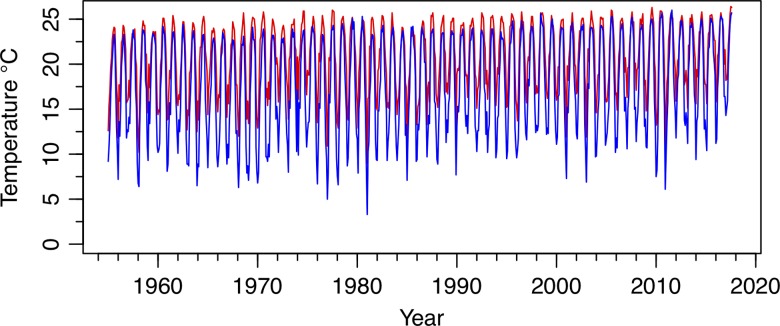
Temperature trends in Tampa (blue) and Miami (red) Florida from 1955 to 2017 (National Oceanic and Atmosphere Administration, 2017). Graph represents yearly temperature profiles for both localities based on the average low temperature for each month. Although localities are similar in summer, Tampa consistently has lower minimum temperatures during winter.